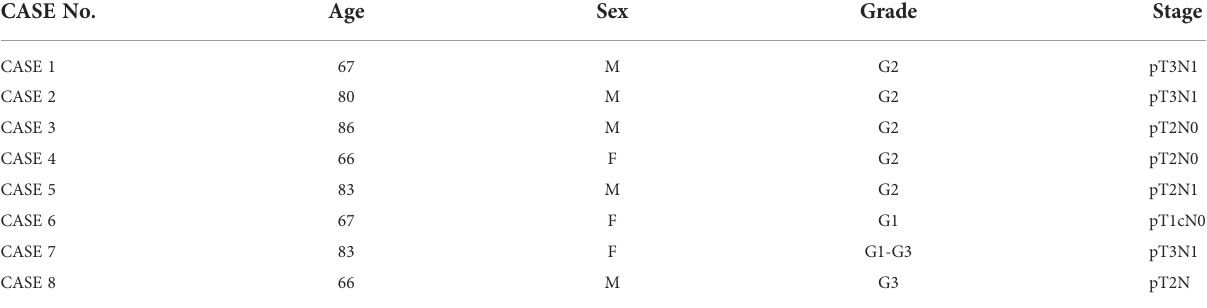
TABLE 1 Patient characteristics.